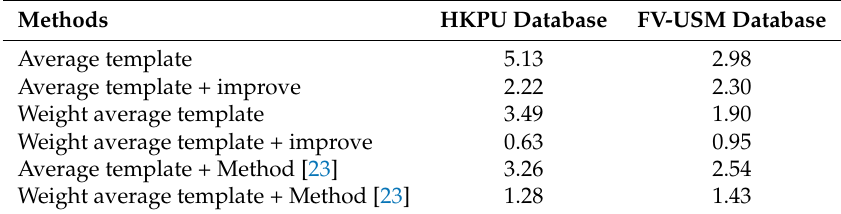
Figure 14. Performance of various methods on ( a ) HKPU Database and ( b ) FV-USM Database. Table 3. Equal error rate of various approaches on both